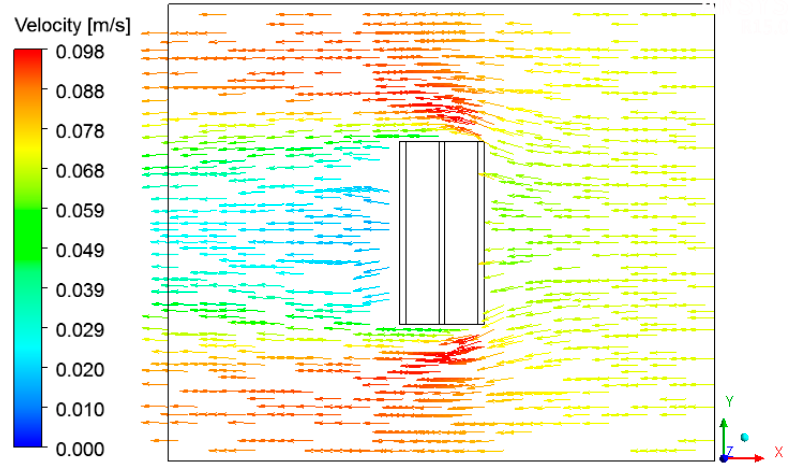
Figure 18. Vector field of the air in the plane XY (Z = 0.197 m) at the instant 950 min.